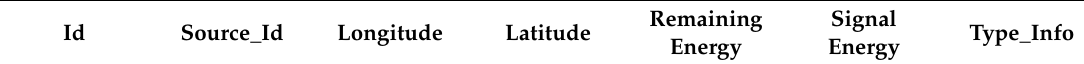
Table 4. Notification packet